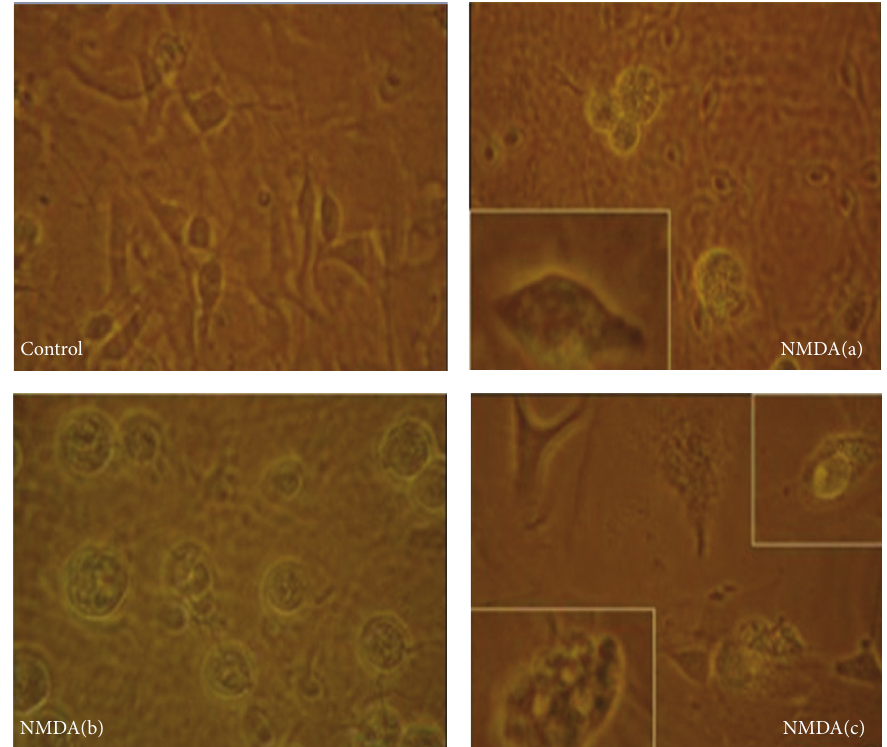
Figure 1: Morphological changes of cortical neurons induced by NMDA. Representative images of control and NMDA-treated cortical neurons (a, b, and c) were observed under phase-contrast light microscope.